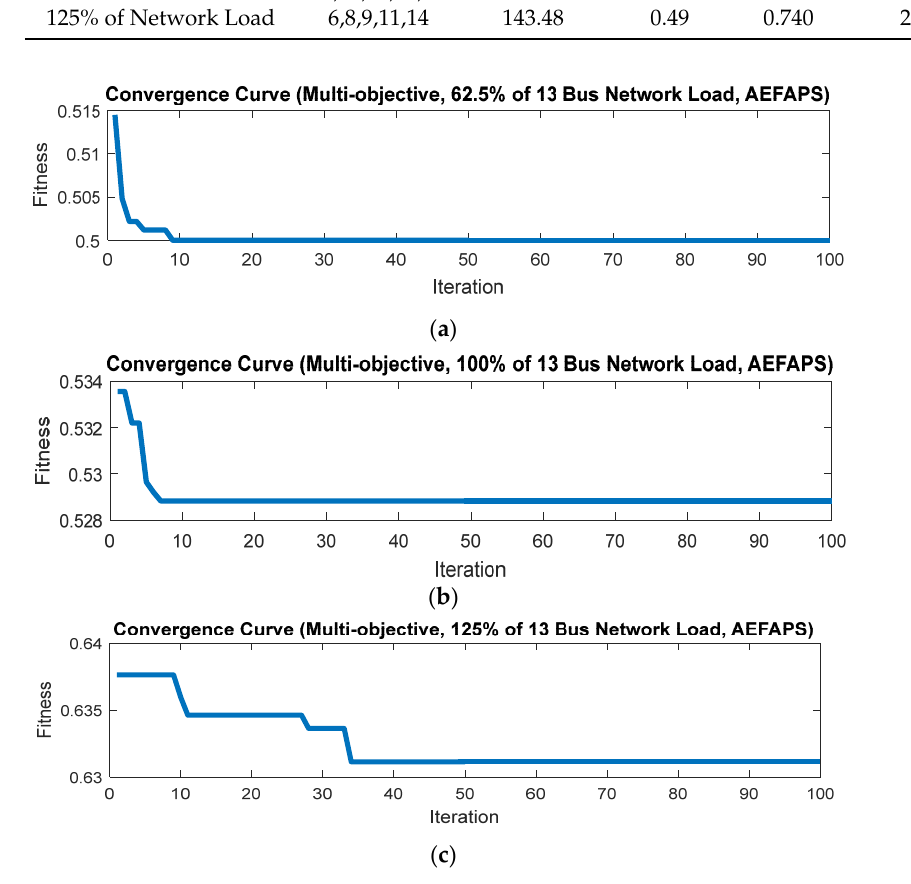
Figure 17. Convergence curve of the AEFAPS method in many-criteria reconfiguration: ( a ) 62.5%, ( b ) 100%, and ( c ) 125% of network load.